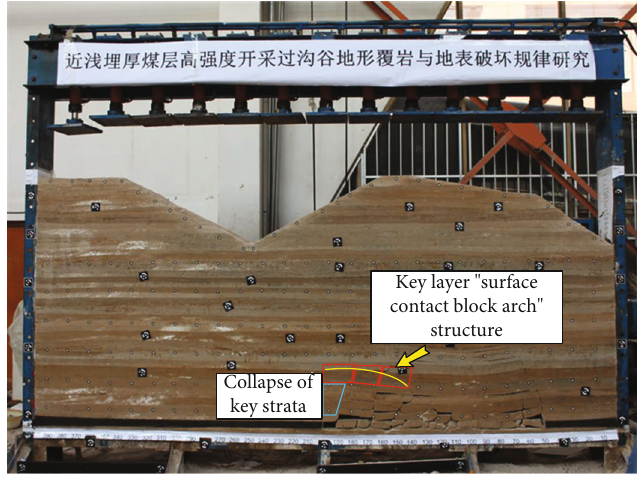
Figure 4: Graph of simulation results.